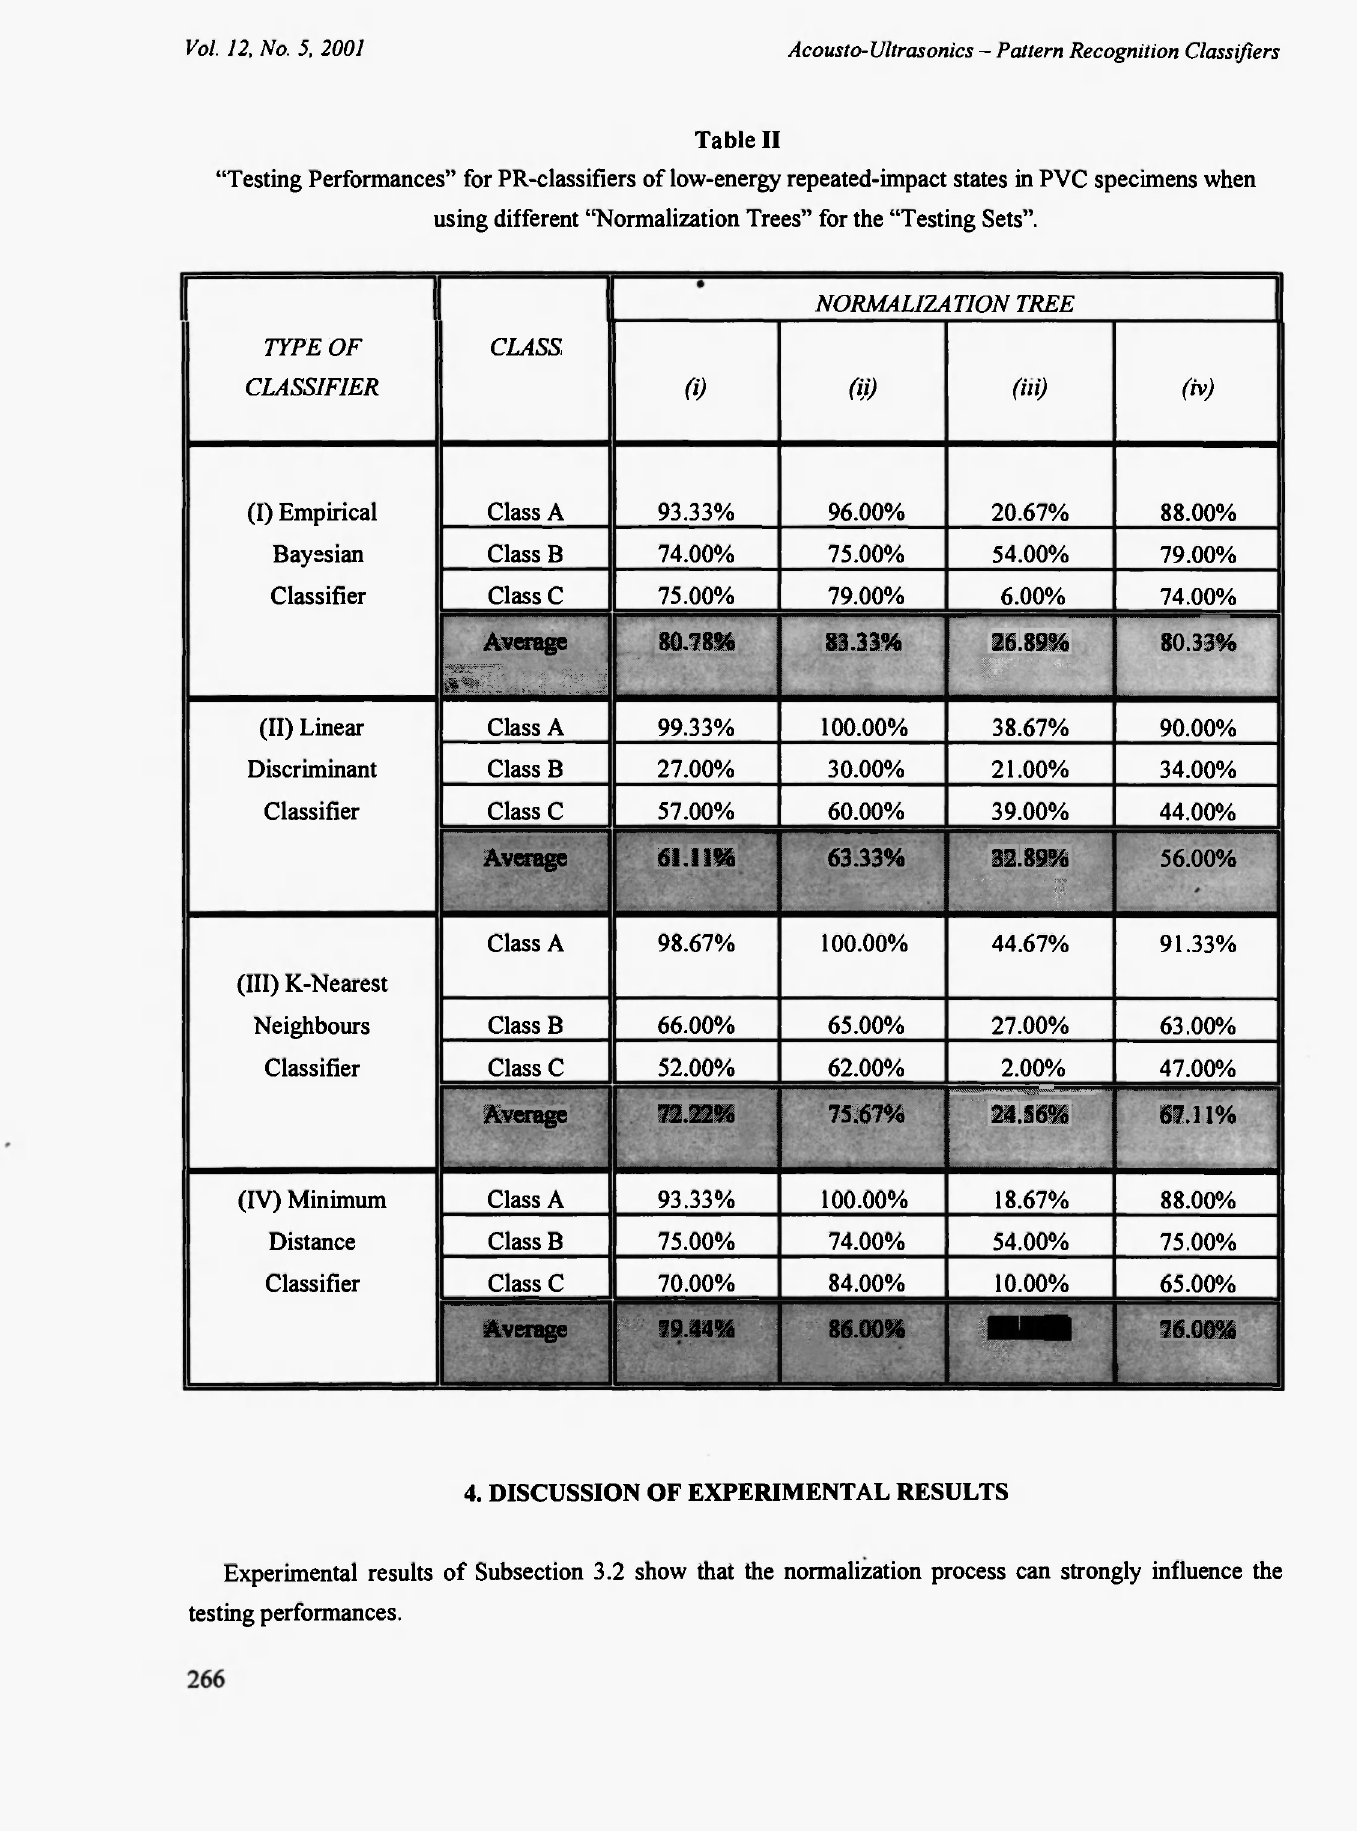
"Testing Performances" for PR-classifiers of low-energy repeated-impact states in PVC specimens when using different "Normalization Trees" for the "Testing